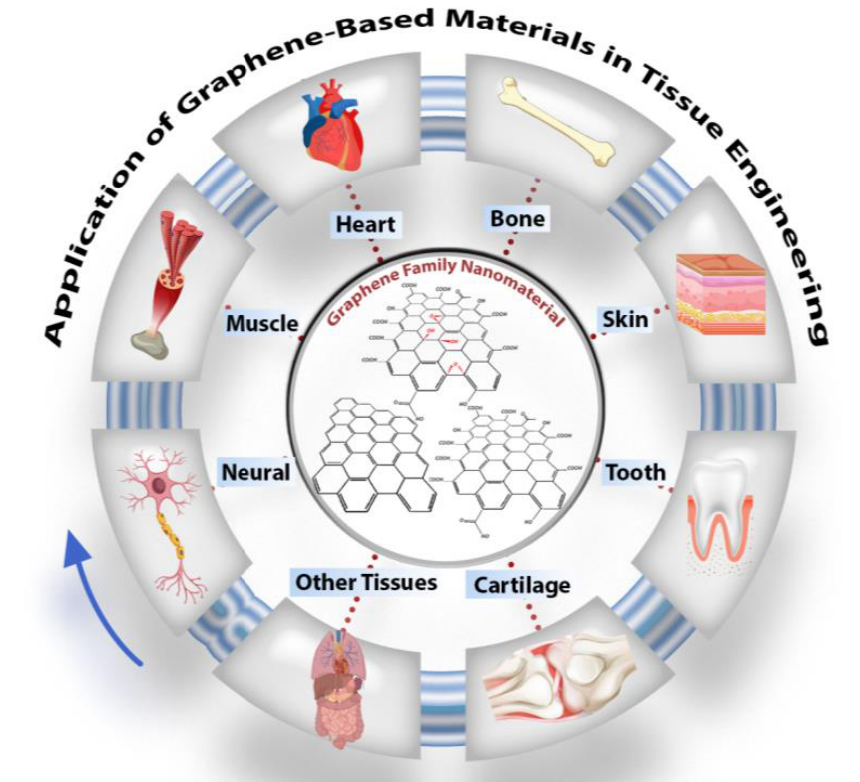
Figure 1. Schematic of graphene oxide nanomaterials and their application in tissue engineering, particularly in nerve, muscle, heart, skin, cartilage, dental, and other tissues. In this review, graphene oxide (GO), reduced graphene oxide (rGO), and function- alized GO (FGO) are noted among the various allotropic forms of carbons due to their significant surface area, strength, light weight, chemical stability, enhanced cell adhesion, proliferation, differentiation, and application in the repair of tissue [4,5]. The basic structure of all carbon allotropes is graphene; it is a single sheet of sp 2 -hybridized carbon atoms ar- ranged in a hexagonal lattice-like honeycomb. Valuable research has completely described the synthesis method, but in brief, the synthesis approach was divided into top-down and bottom-up strategies. In the top-down approach, graphite is treated by exfoliation (mechanical or electrochemical). The bottom-up approach is a developed approach, which contains epitaxial growth, chemical vapor deposition, and the dry ice method for graphene material production [6–8] (Figure